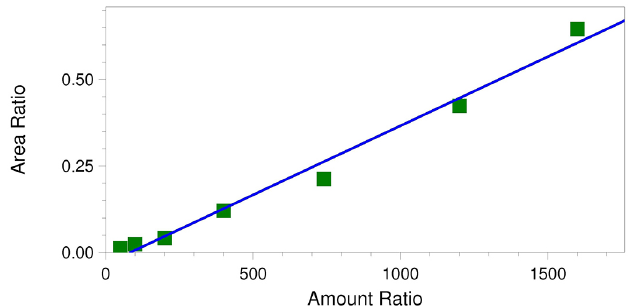
FIGURE 3 - Calibration curve of HU in the range of 50-1600 µM hydroxyurea in human